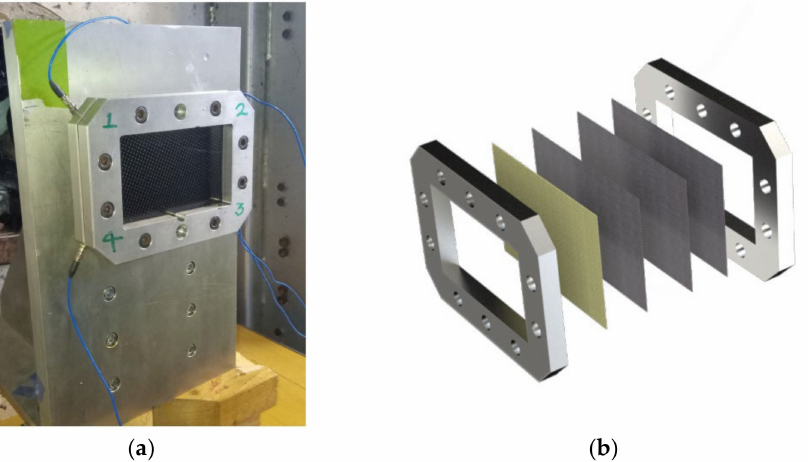
Figure 3. ( a ) Image of the holding of the sample for gas gun testing and ( b ) representation of the frame and panel layers. Table 3. Summary of the impact tests conducted and their details (“p”: full penetration of the panel).